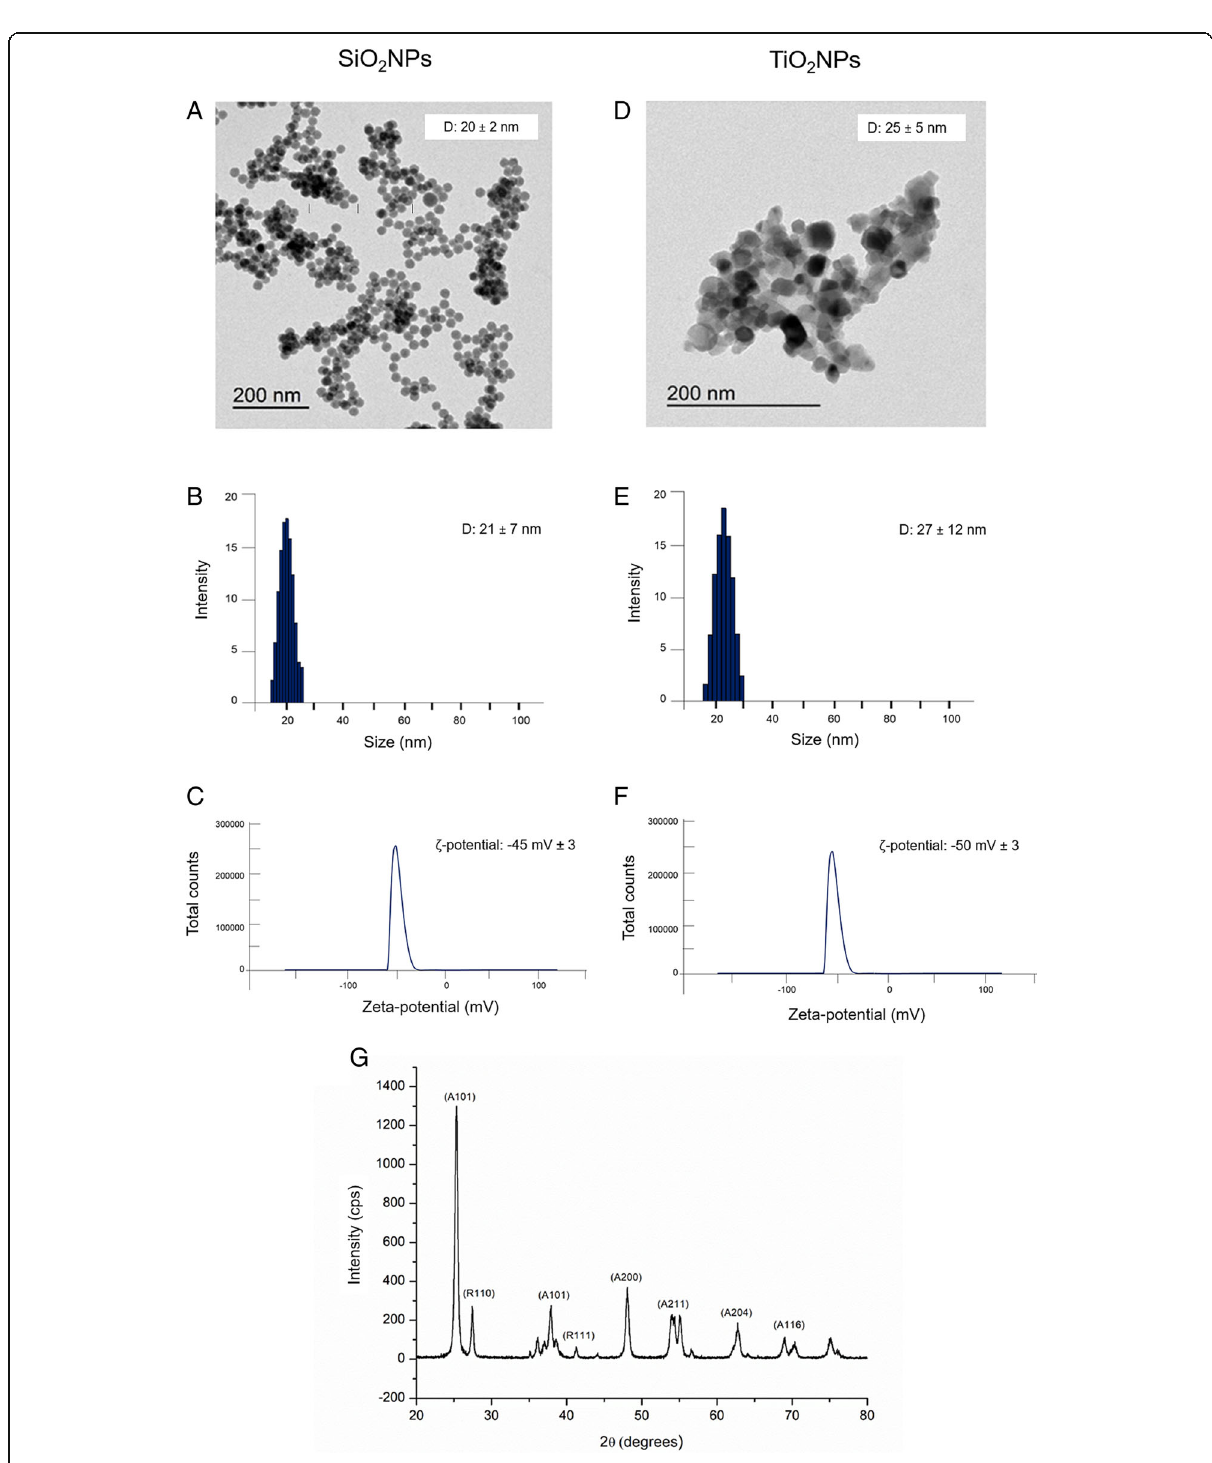
Fig. 1 Characterizations of SiO 2 NPs and TiO 2 NPs in water. a – d Representative TEM images. b – e Dynamic light scattering (DLS) and c – f ζ -potential measurements. g X-ray diffraction analysis (XRD) pattern of TiO 2